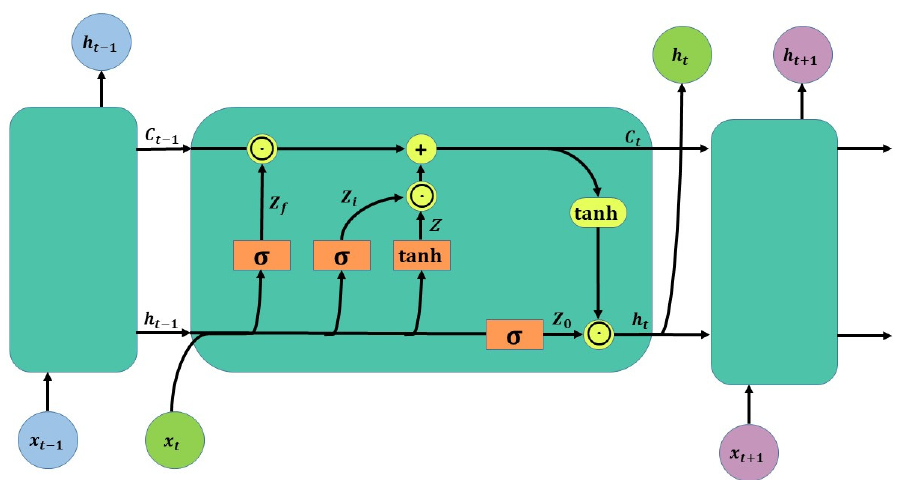
Figure 4. Structure of Figure 4. structure of LSTM.